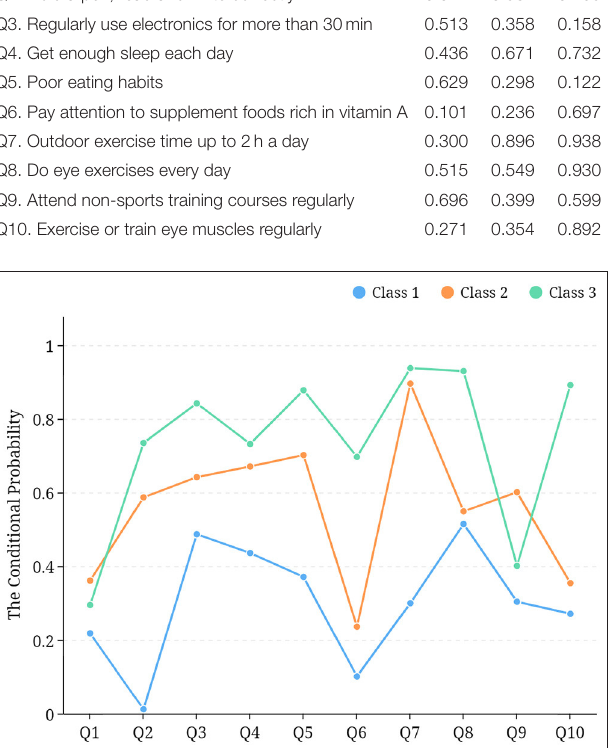
FIGURE 2 | Line chart of latent classes of adolescent eye care behavior. *Q1: Frequent close eye contact for more than 40min; Q2: Hold a pen, read, and